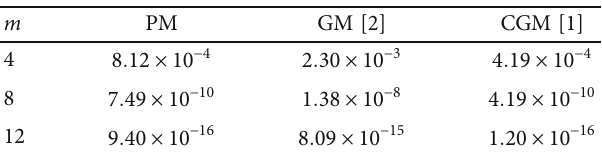
Table 2: Maximum absolute errors for Example 2 at di ff erent degrees of approximation m